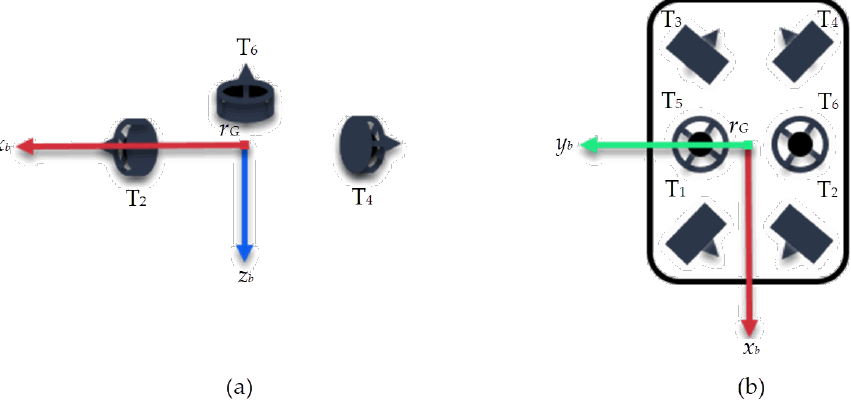
Figure 2. BlueROV2 thruster configuration. ( a ) Right view. ( b ) Top view.